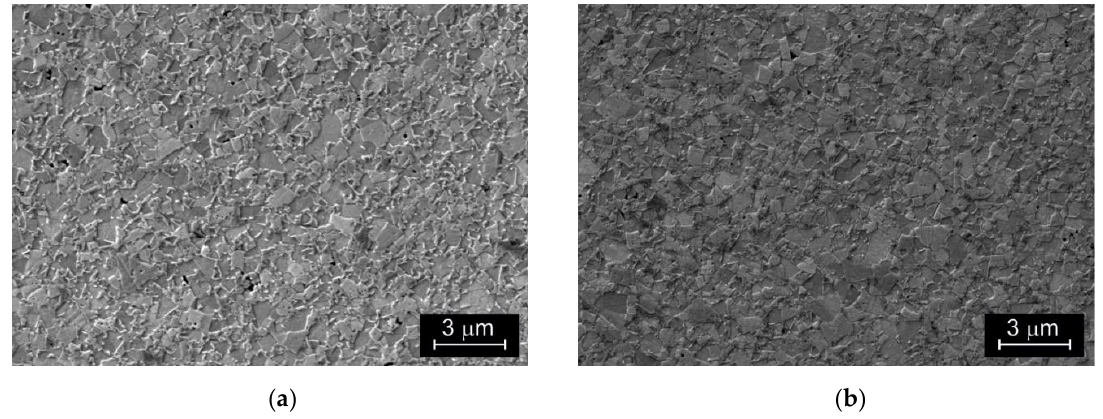
Figure 6. Secondary electron field emission gun SEM (FEGSEM) images of WC6Co compacts sintered at 9 kA–600 ms. Images correspond to positions ( a ) 3 and ( b ) 5 of the axial section of the compact.